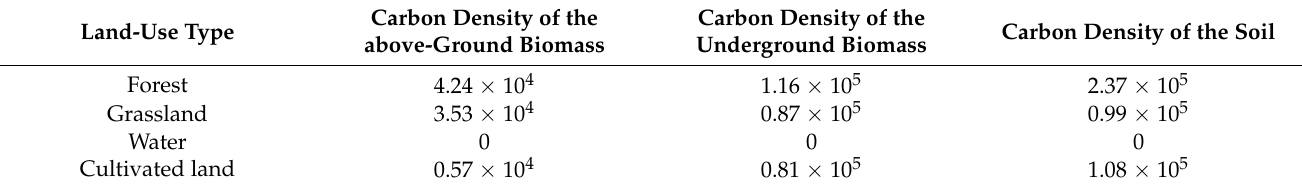
Table 2. The carbon density of three carbon pools corresponding to each land use (kg/hm 2 ).